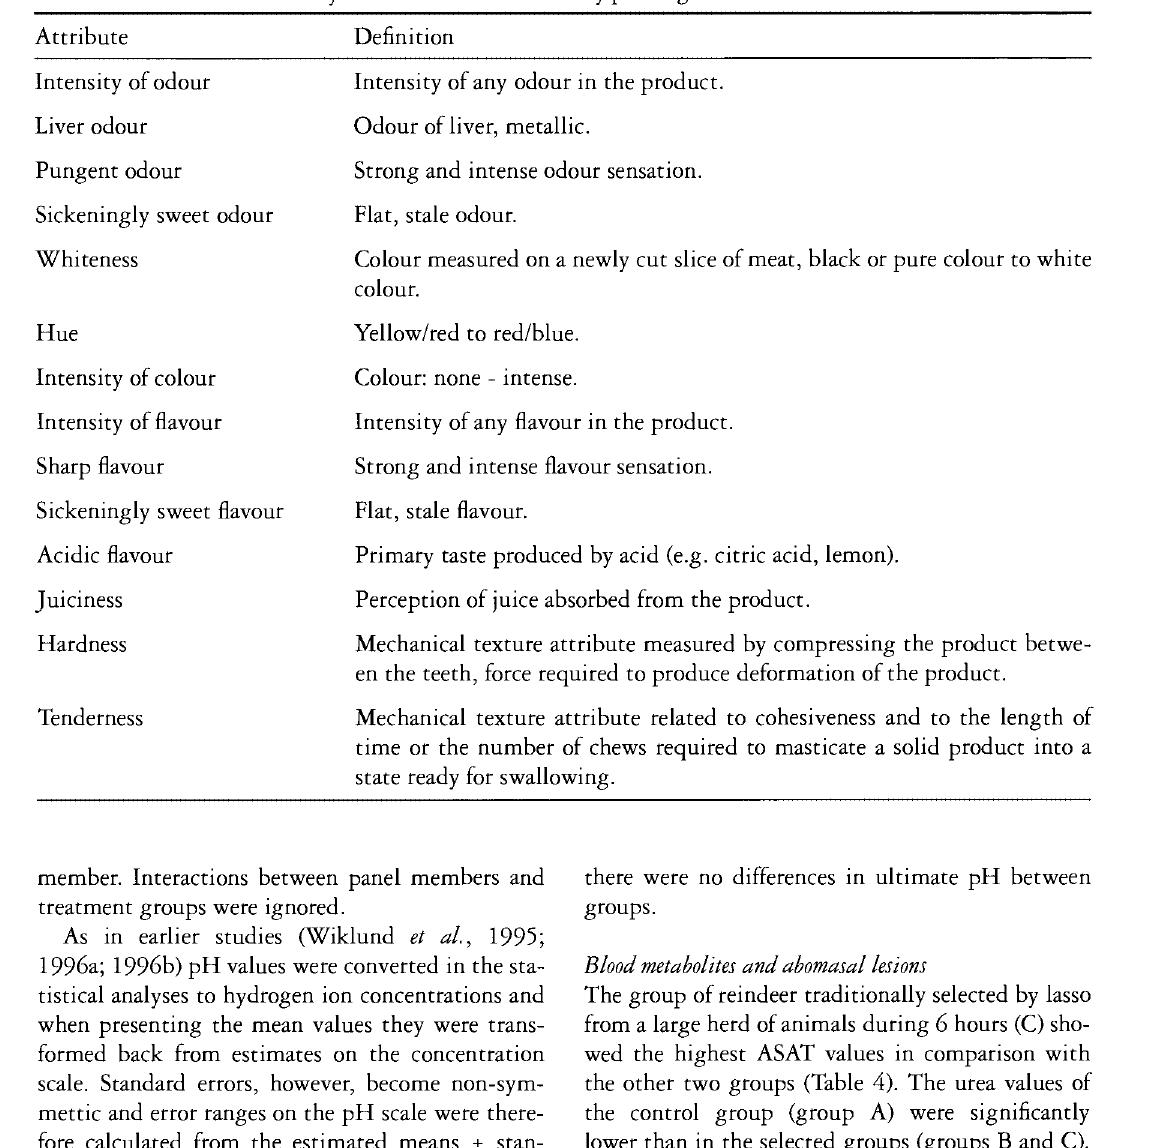
Table 2. Definitions of the sensory attributes used in the sensory profiling of the reindeer